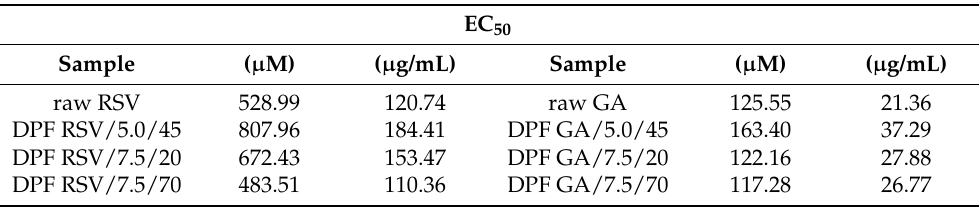
Table 6. EC 50 values of unprocessed and SASD-processed RSV and